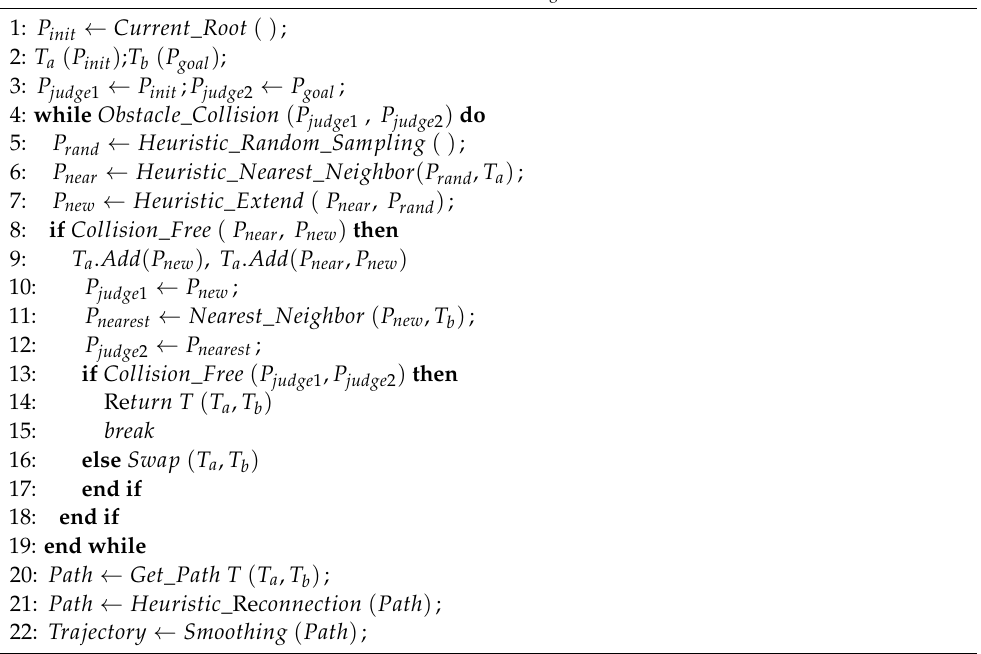
Algorithm 3: Build Improved Heuristic Bi-RRT ( P init , P goal